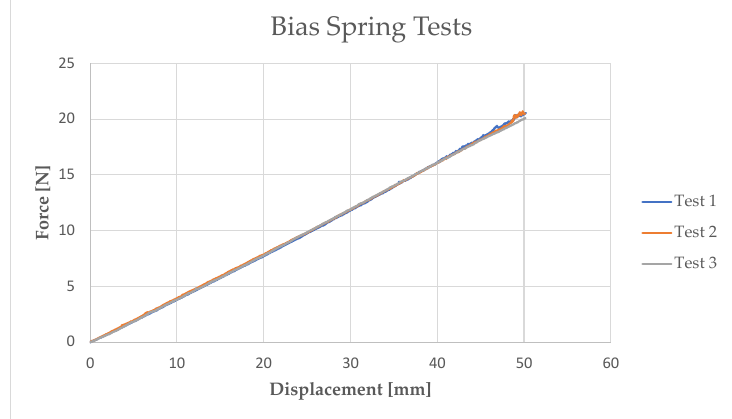
Figure 6. Bias (steel) spring compression tests.